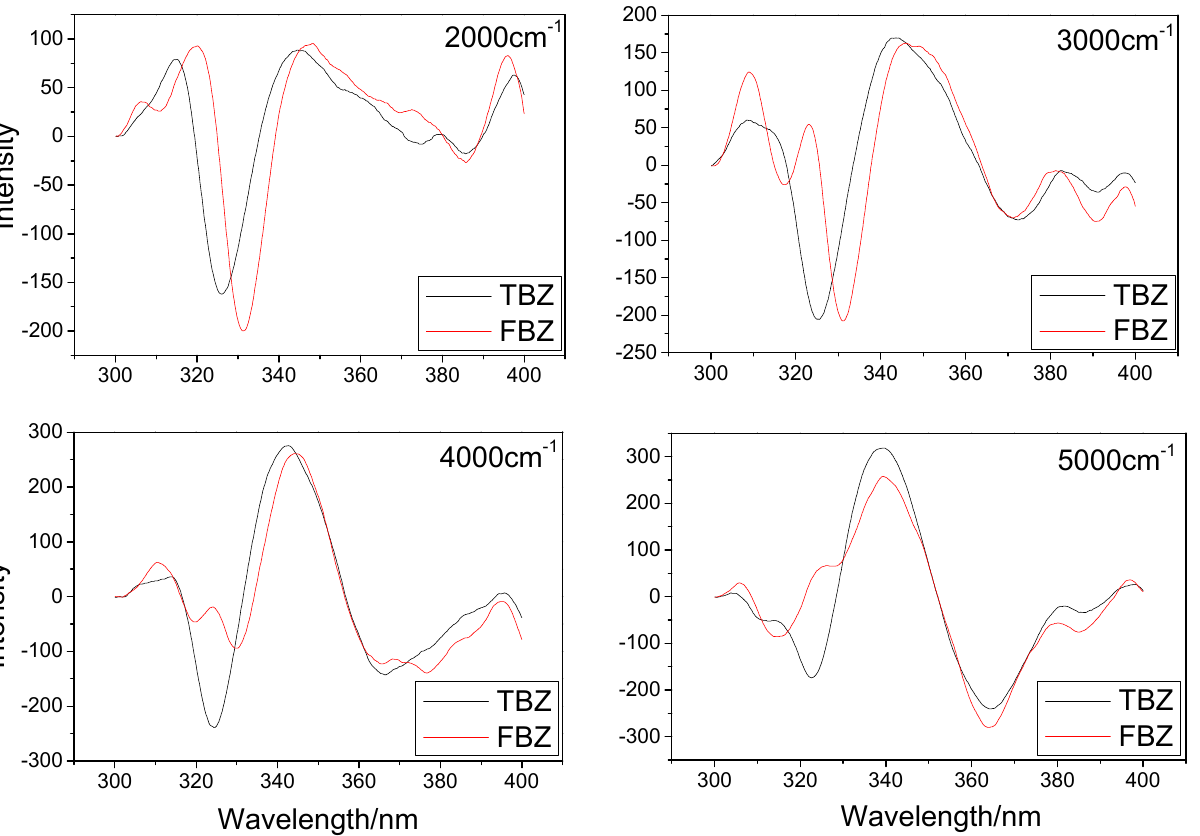
Figure 6. Dilution method: second derivative constant-energy synchronous fluorescence spectra of TBZ (300 ng/mL) and FBZ (30 ng/mL) spiked in diluted wine sample at different constant-energy differences (cm − 1 ).